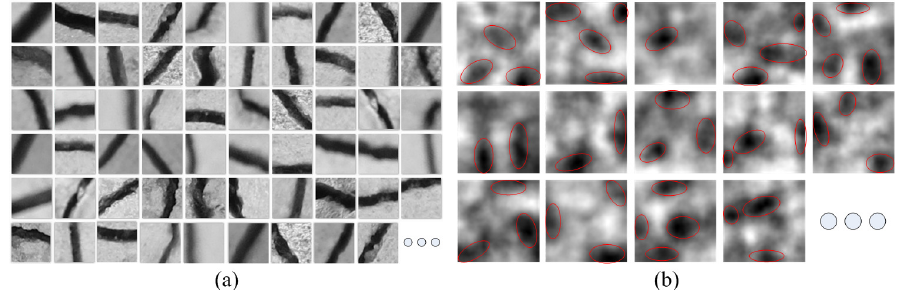
Figure 3. Illustration of ELM auto-encoder (ELM-AE) feature learning: ( a ) The input crack region instances, and ( b ) the contents of the output weights γγγ